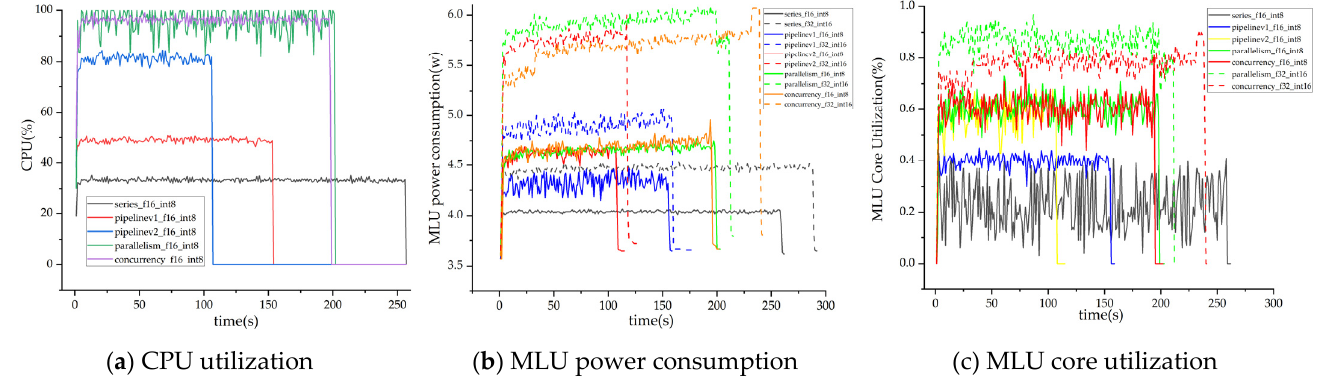
Figure 12. Effect of differently structured methods on hardware utilization and power consumption. ( a ) The change in CPU utilization when the five structures in Figure 5, respectively, are running; ( b ) the effect of different strategies on NPU power consumption; and ( c ) the effect of different strategies on NPU core utilization.